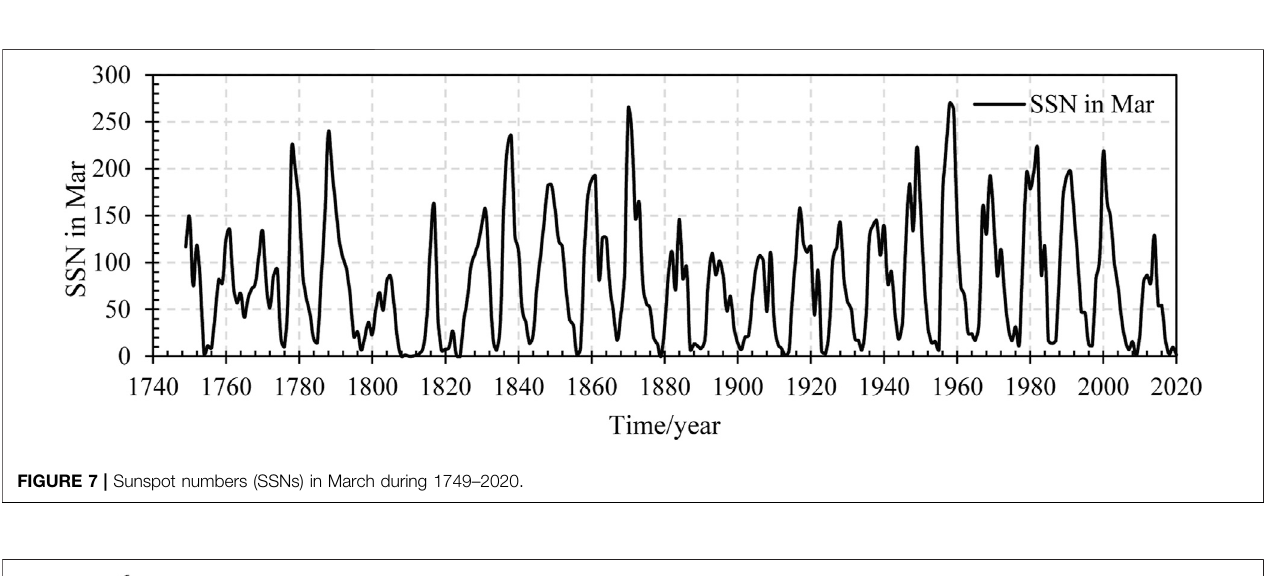
FIGURE 6 | Variation of annual peak discharge before and after the Three Gorges Dam (TDG) construction.